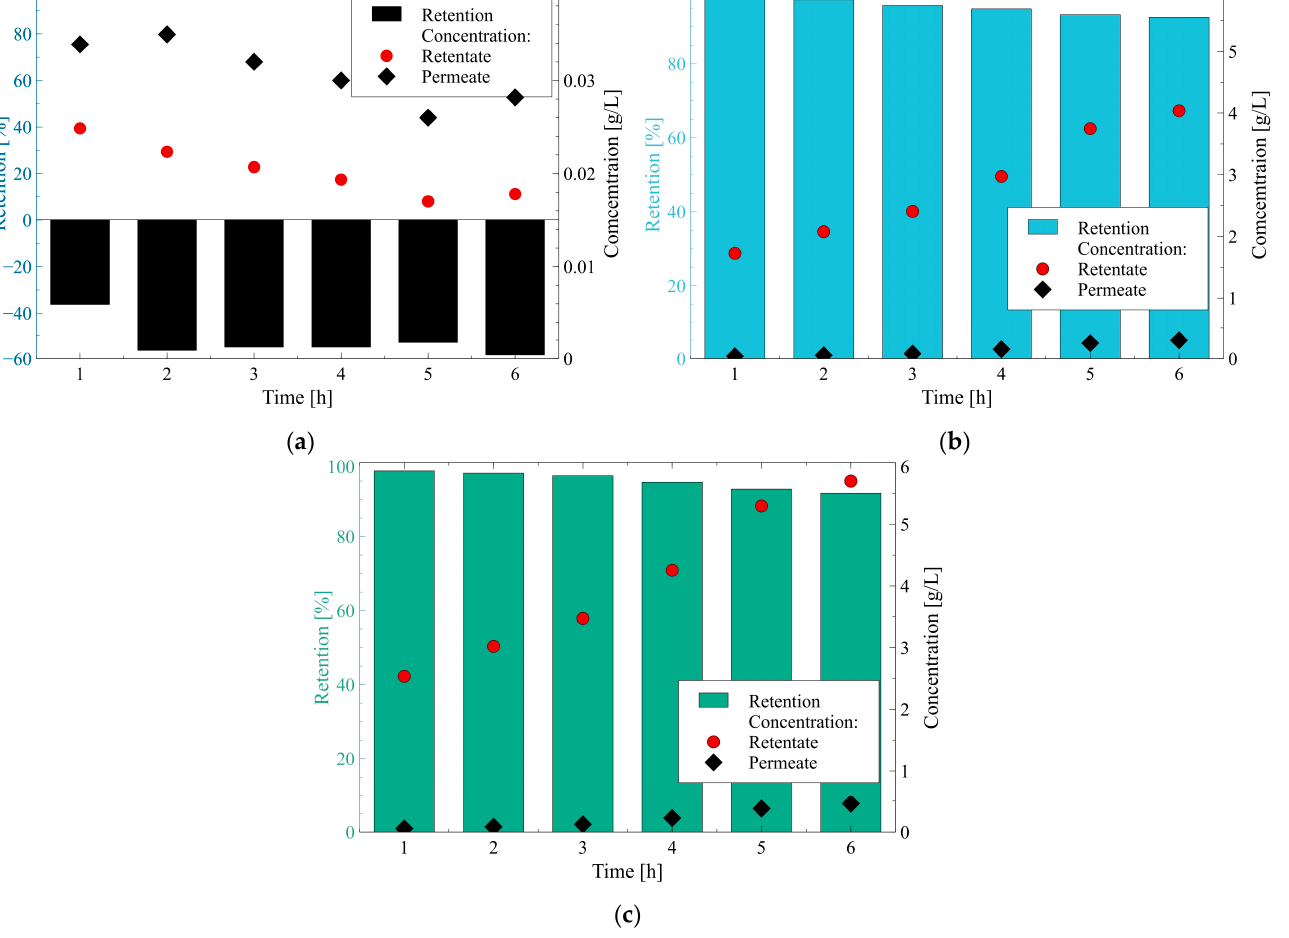
Figure 10. Changes in retention and concentration of the ions during the NF process of fermentation broth: ( a ) Cl − ; ( b ) SO 42 − ; ( c ) PO 43 − . TMP = 1.4 MPa, T = 298 K. broth: ( a ) Cl − ; ( b ) SO 42 − ; ( c ) PO 43 − . TMP = 1.4 MPa, T = 298